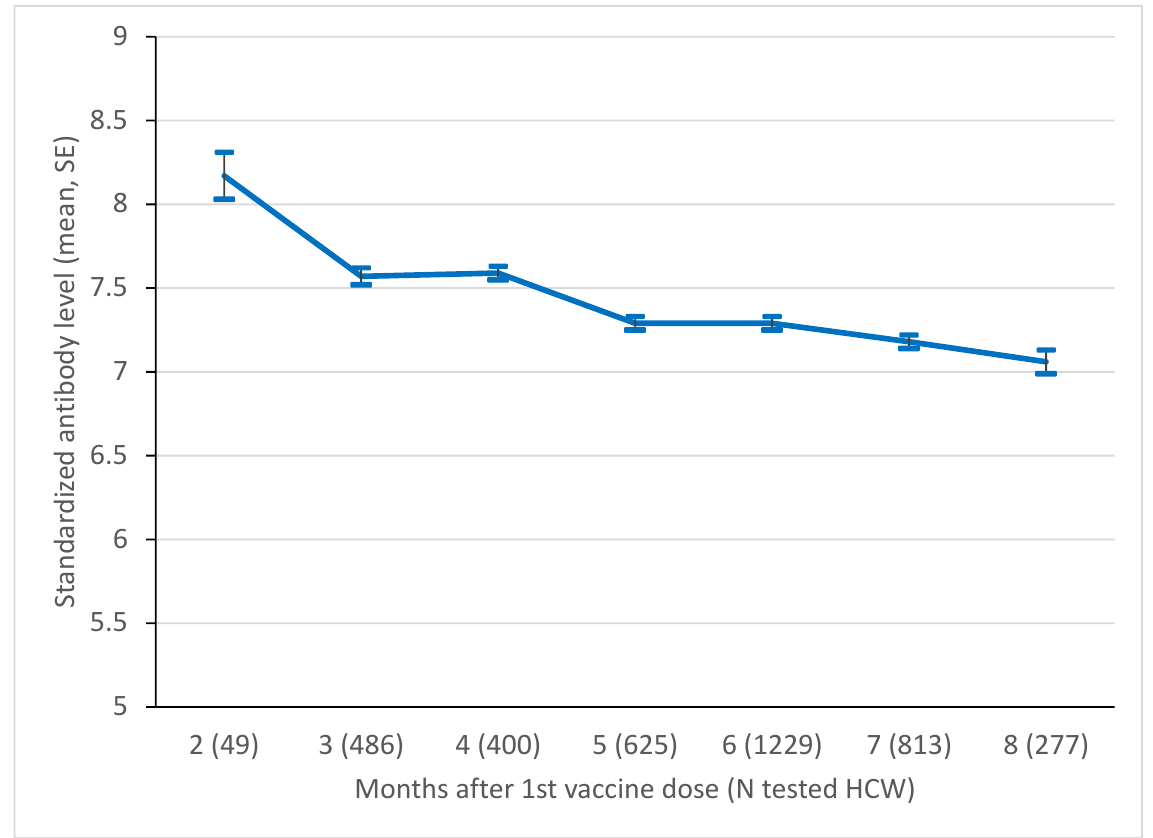
Figure 1. Mean level of standardized log anti-S level in the Bologna cohort, by month since 1st vaccine dose. SE, standard error. p -value of test for linear trend = 0.005.